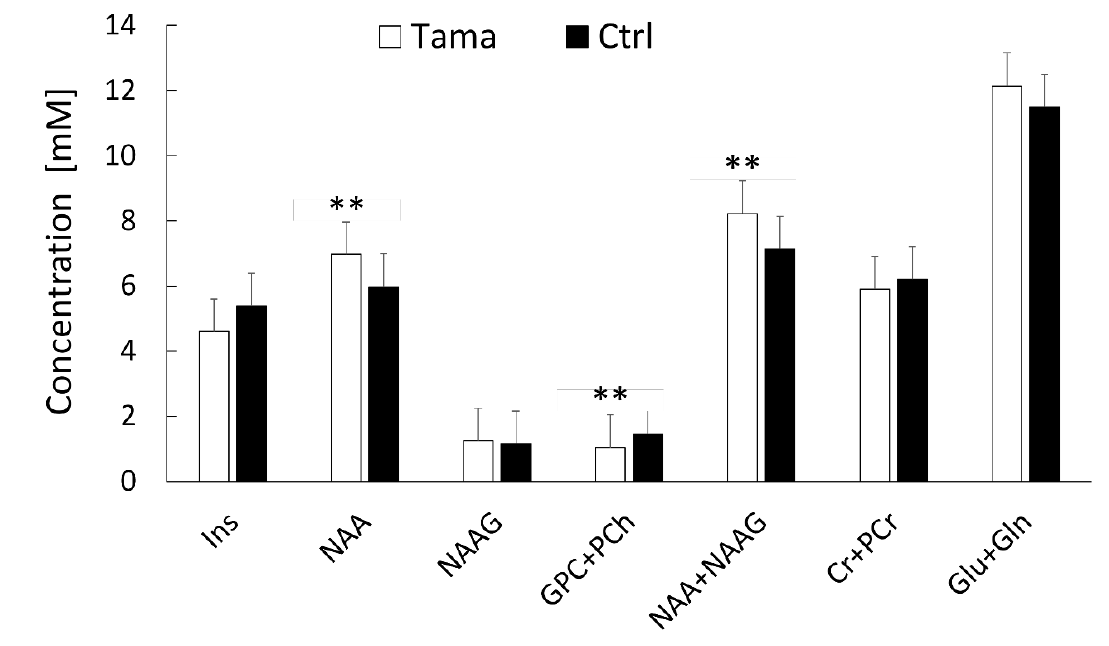
Figure 5. 1 H-MRS was performed, and the metabolite concentrations of the Tama and control rats (Ctrl) were measured. The metabolites included myoinositol (Ins), N-acetylaspartate (NAA), N-acetylaspartylglutamate (NAAG), glycerophosphocholine + phosphocholine (GPC +PCh), creatine + phosphocreatine (Cr + PCr), glutamate (Glu), and glutamine (Gln). The concentrations of NAA, GPC + PCh, and NAA + NAAG of the Tama rats showed ** p < 0.01 compared with the control rats.